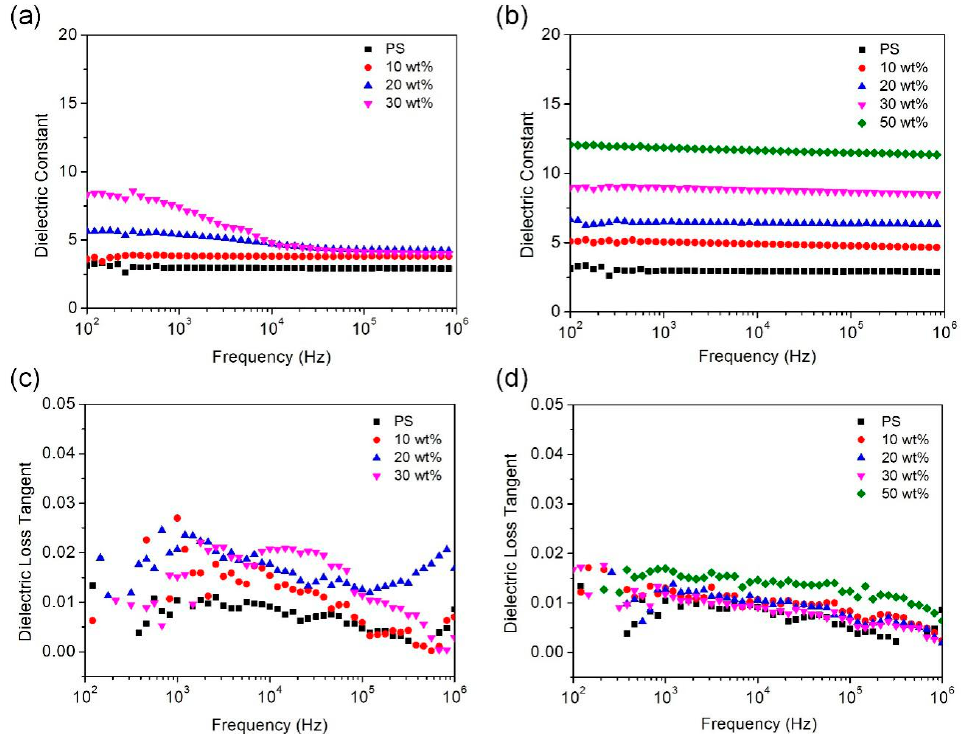
Figure 4. Dielectric constant of pure PS films and Al/PS composite films ( a ) PS film doped with agg - Al NPs and ( b ) PS film doped with iso -Al NPs@PS. Dissipation factor of pure PS films and Al/PS